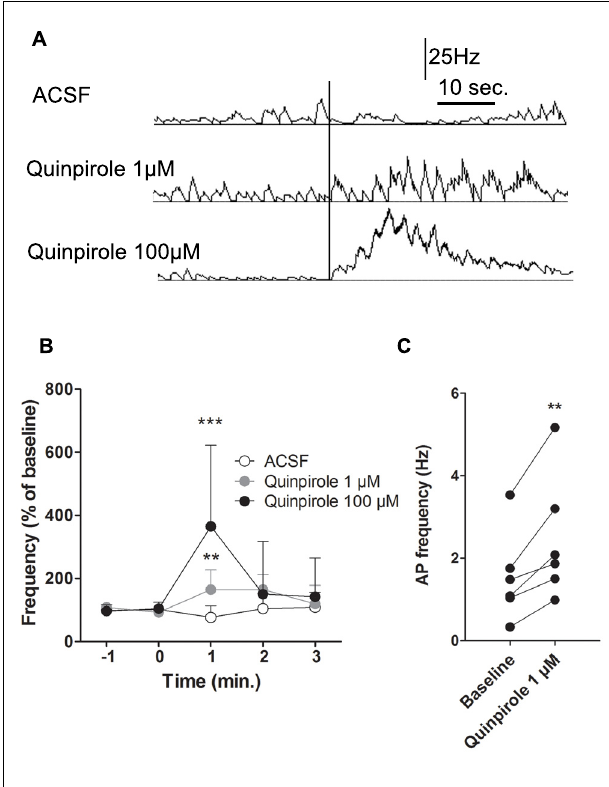
FIGURE 5 | Intracortical injection of D 2 agonist quinpirole or ACSF. (A) Typical recording of a putative pyramidal neuron 30 s before and 40 s after an injection of ACSF (upper panel), 1 μ M (middle panel) or 100 μ M quinpirole (lower panel). (B) Effect of an injection of ACSF on the mean AP firing frequency of putative pyramidal neurons ( n = 5) in white. Effect of an injection of 100 μ M quinpirole on the mean AP firing frequency of putative pyramidal neurons ( n = 4) in black. Effect of an injection of 1 μ M quinpirole on the mean AP firing frequency of putative pyramidal neurons ( n = 6) in grey. (C) Individual responses of putative pyramidal neurons to 1 μ M quinpirole. (A) The vertical black line represents the injection. (B) ** p < 0.01; *** p <